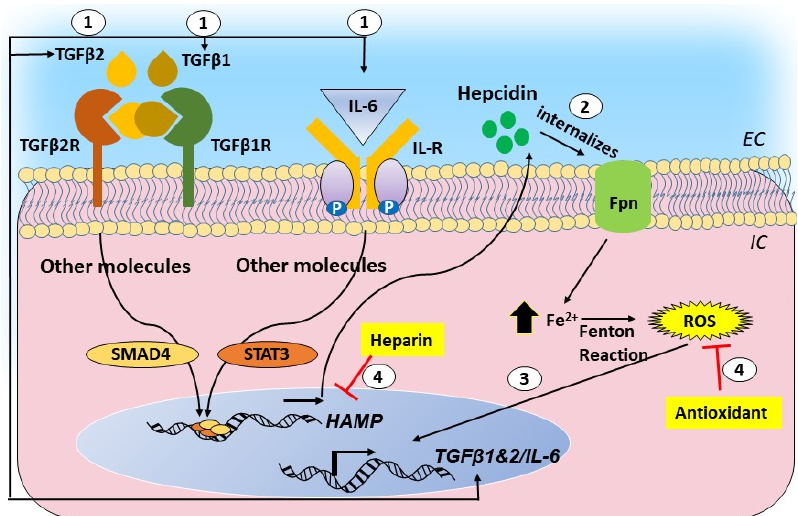
Figure 3. Graphical representation of the cytokine-hepcidin-iron feed-forward loop and its disruption by hepcidin antagonists and antioxidants: (1) transforming growth factor beta 1 and 2 (TGF-β1 and 2) and interleukin (IL)-6 upregulate hepcidin through the SMAD and signal transducer and activator of transcription (STAT)-mediated pathways. (2) Hepcidin causes the downregulation of ferroportin and intracellular accumulation of iron. (3) Iron-catalyzed ROS promotes the transcriptional activation of TGF-β1 and 2 and IL-6, creating a self-sustained feed-forward loop. (4) Hepcidin antagonists and antioxidants disrupt this loop.